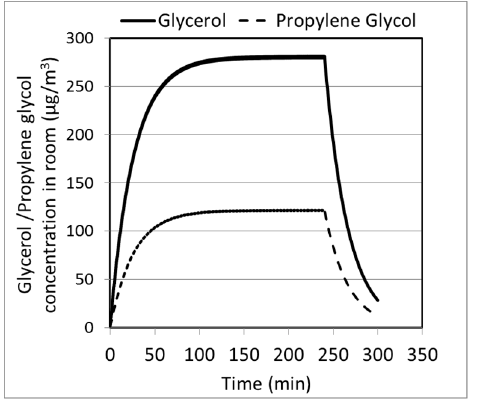
Figure 10. Model predictions for glycerol and propylene glycol concentrations in the mEEC.